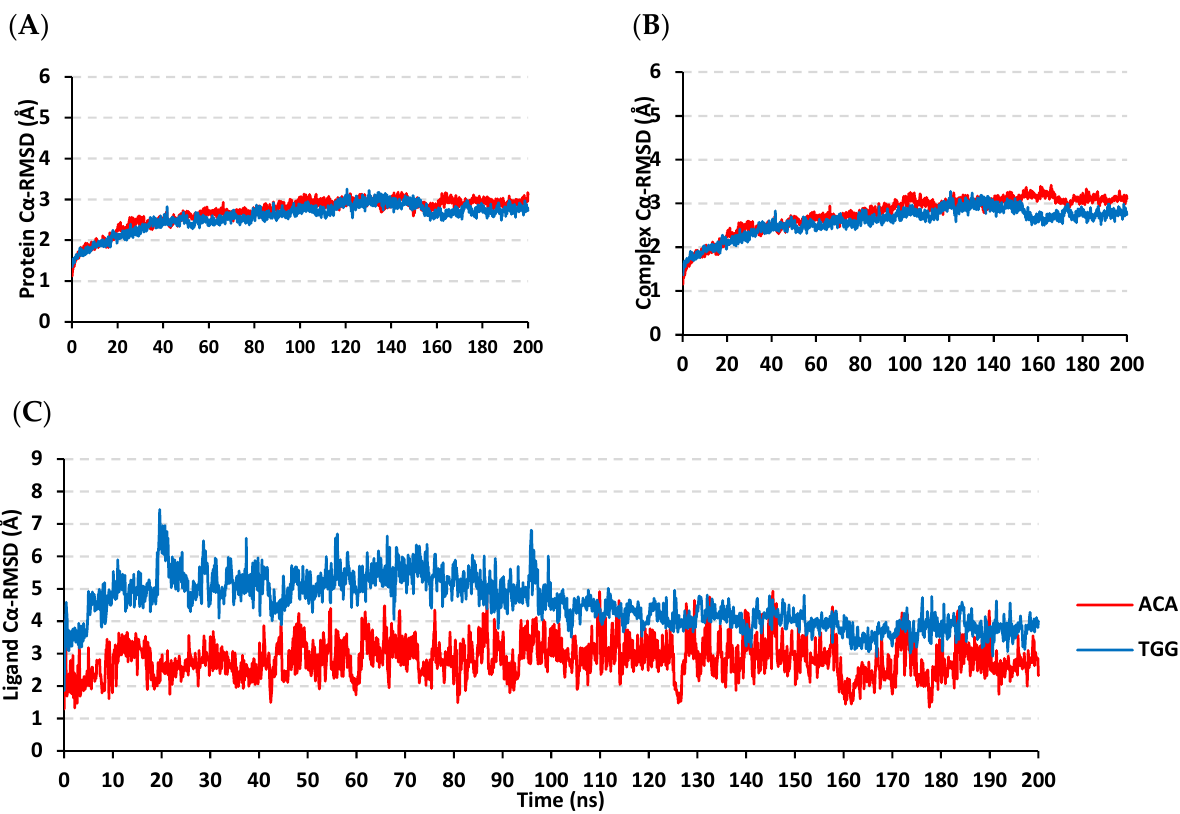
Figure 7. Stability analysis for the investigated gallotannin derivative and reference inhibitor, acar- bose, in complex with h MGAM protein along 200 ns explicit MD simulation. ( A ) Protein C α -RMSDs; ( B ) Complex C α -RMSDs; ( C ) sole ligand C α -RMSDs (Å) in reference to protein backbone C α -carbon atoms, across MD simulation time (ns); ACA (acarbose); TGG (1,3,6-trigalloyl glucose). Examining the models at trajectories of the start, midway, and final timeframes (0 ns, 100 ns, and 200 ns), was beneficial for monitoring the possible conformational changes of the simulated ligand-protein models across the MD simulation run. Designated frames for each ligand-protein model were extracted and minimized to a 0.001 kcal/mol.A 2